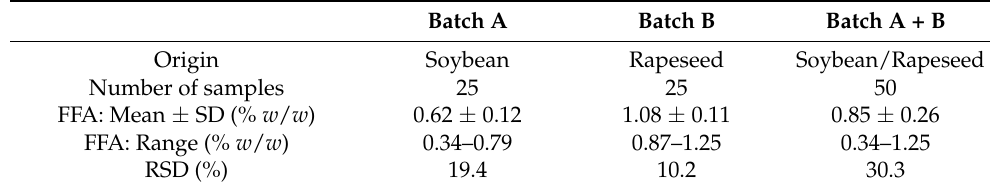
Table 1. Statistical data on reference FFA measurements. SD = standard deviation, RSD = relative standard deviation = (SD/mean)·100.